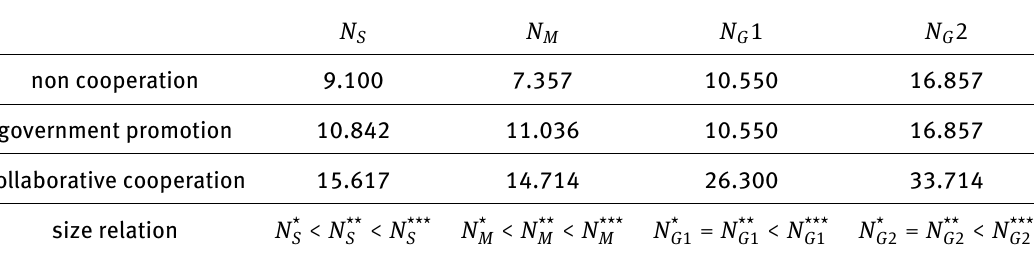
Table 2: Green supply chain and government effort level under different